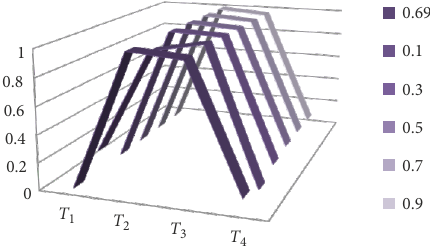
Figure 2. When parameter b changes alone, the results of ℑ ( T k ) in different